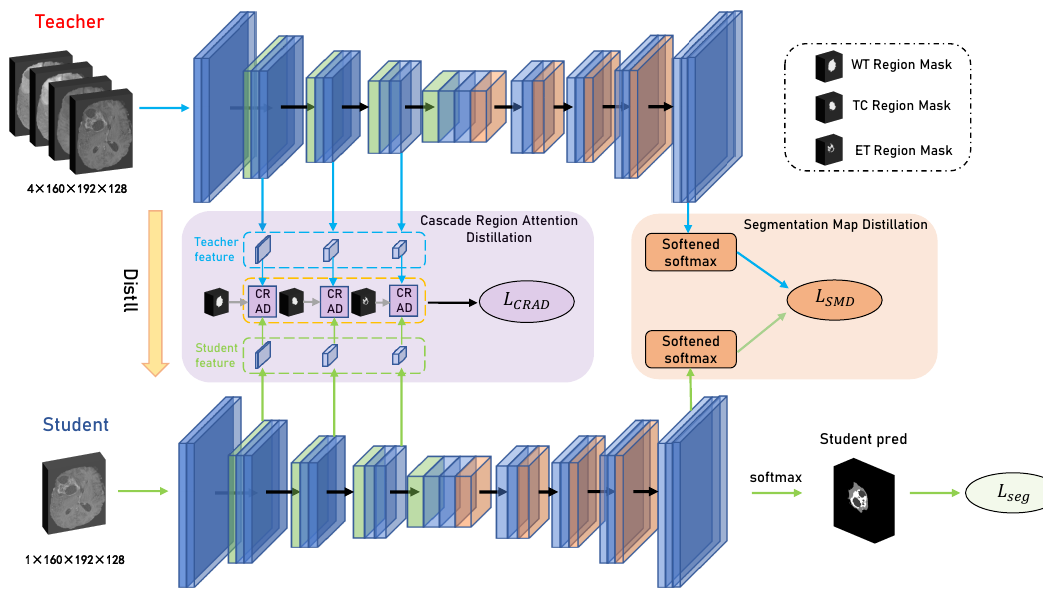
Figure 2. The presentation of our proposed distillation framework. Two networks, one for the teacher model and the other for the student model, are vertically depicted in the framework. The teacher model uses a combination of four modalities as input, and the student model uses one modality as input. The distillation process is separated into two modules, i.e., the Cascade Region Attention Distillation (CRAD) module and the Segmentation Graph Distillation (SMD)